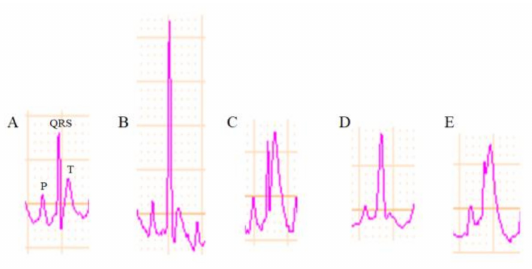
Figure 8. Typical myocardial I/R injury on ECG. ( A ) Normal rat ECG; ( B ) QRS amplitude increase;